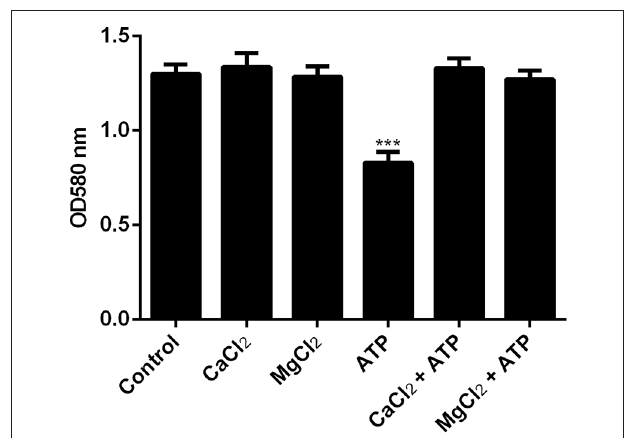
FIGURE 2 | The effects of cations on ATP-mediated dispersal of biofilm. F. nucleatum biofilm was left untreated (control) or treated with MgCl 2 or CaCl 2 in the presence or absence of 1 mM ATP. Biofilm was incubated anaerobically at 37 ◦ C for 1h. The amount of biofilm biomass after induction of dispersal was determined by crystal violet assay. The data presented were obtained from one representative experiment carried out in triplicate. All experiments were performed 3 independent times and showed similar trends (Supplementary Figure 2). *** p <